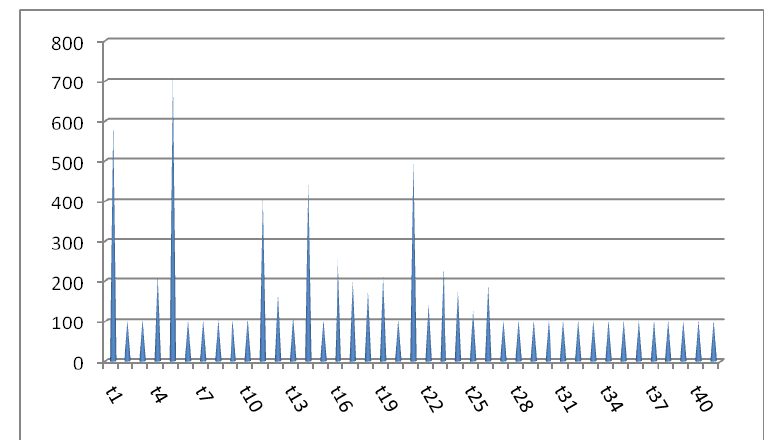
Figure 1. MSE of various estimators